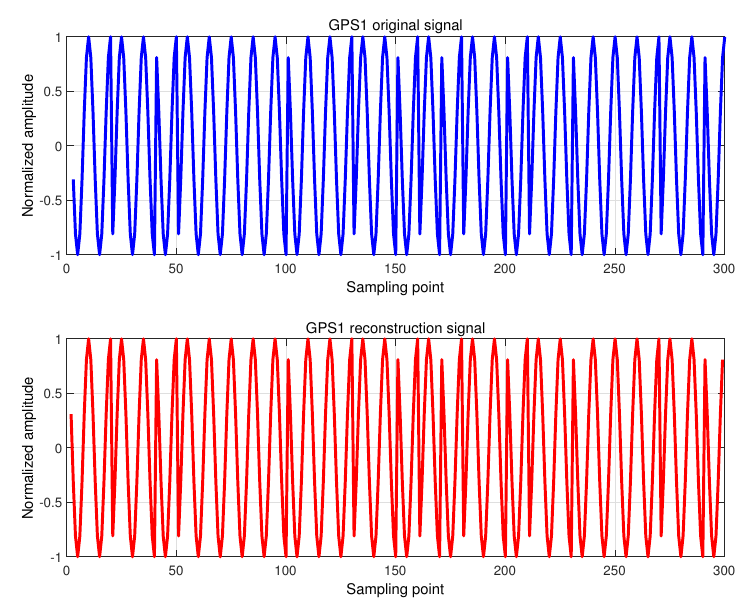
Figure 9. Compare the reconstructed signal with the original